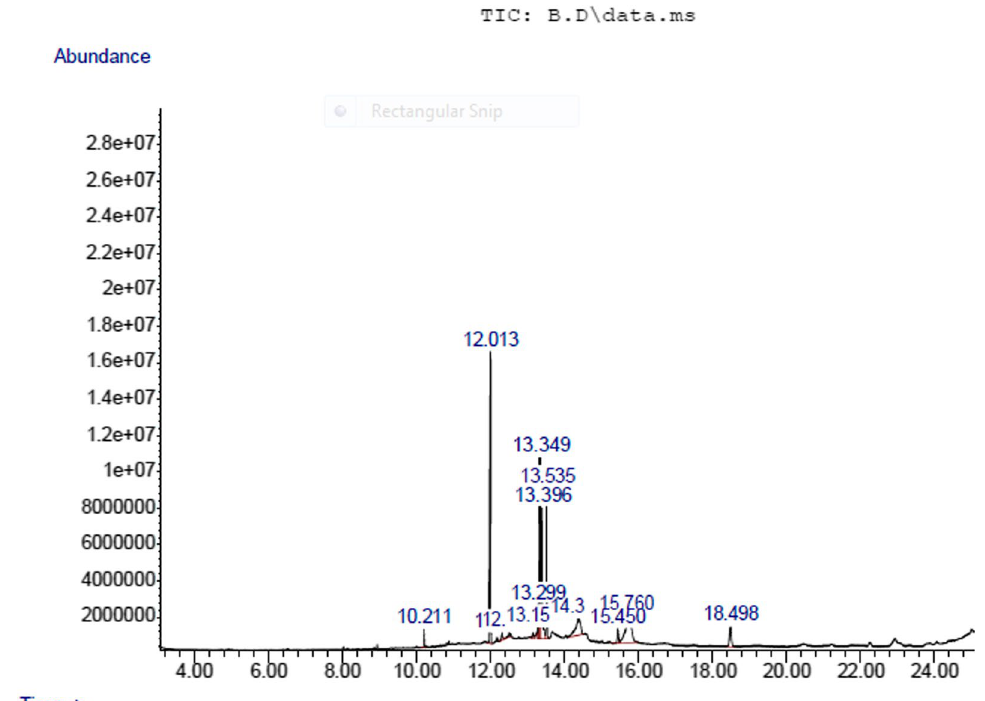
Fig. 8 GC–MS Spectra of Methanol extract of Palisota hirsuta